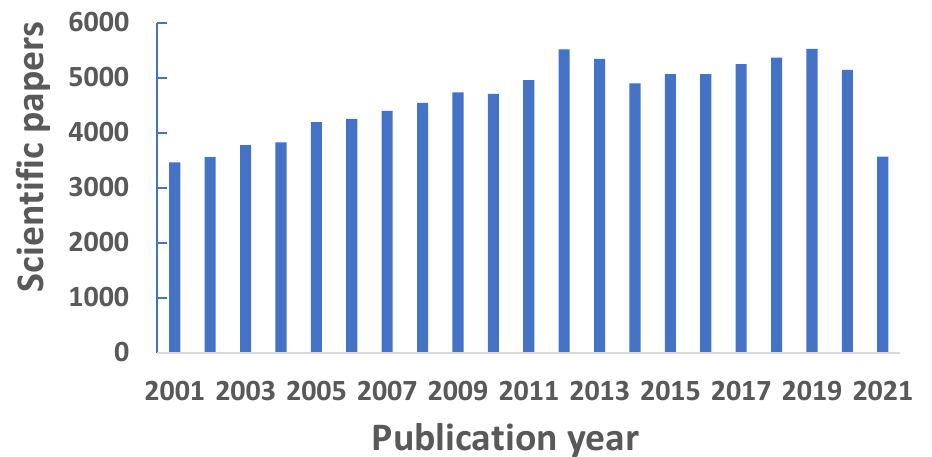
Figure 1. Yearly statistics of scientific papers published between 2001 and 2021 in the research area of laser-induced fluorescence.